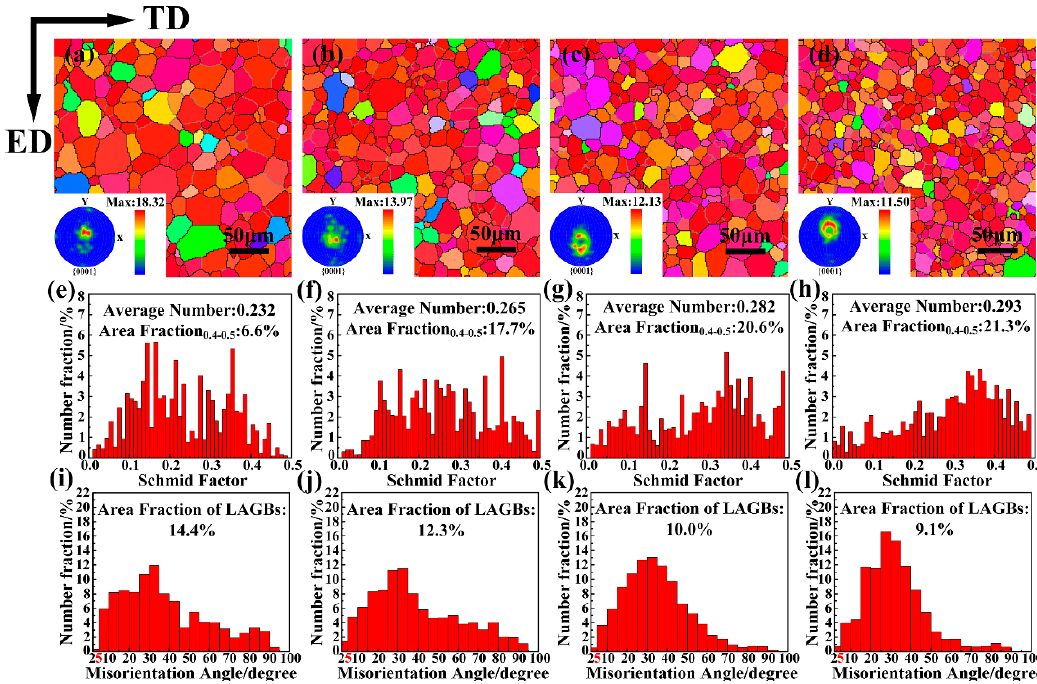
Figure 6. ( a–d ) The electron backscattered diffraction (EBSD) orientation maps and the corresponding {0001} pole figures; ( e–h ) the basal slip Schmid factor distribution histograms; ( i–l ) the misorientation angle distribution histograms (remark: LAGBs stands for low angle grain boundaries with misorientation angles that are larger than 2° but smaller than 15°) of the as-extruded AZ80- x Ce alloys: ( a, e, i ) x = 0; ( b, f, j ) x = 0.2; ( c, g, k ) x = 0.8; ( d, h, l ) x = 1.4.